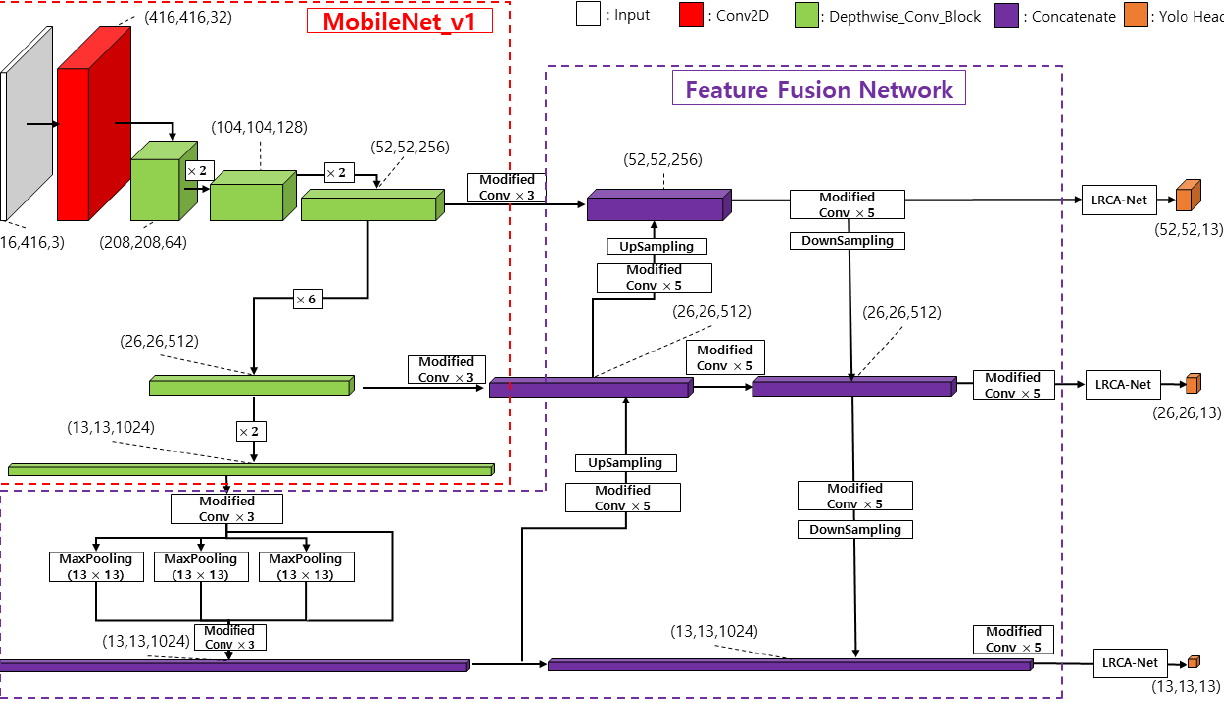
Figure 11. The proposed object detection network.